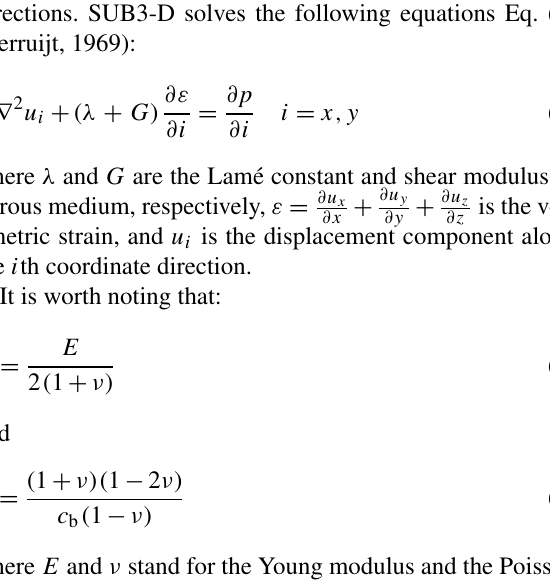
displacements and piezometric head time series, as described in Sect. 3.1, supports the choice of the simulator in the ge- omechanical